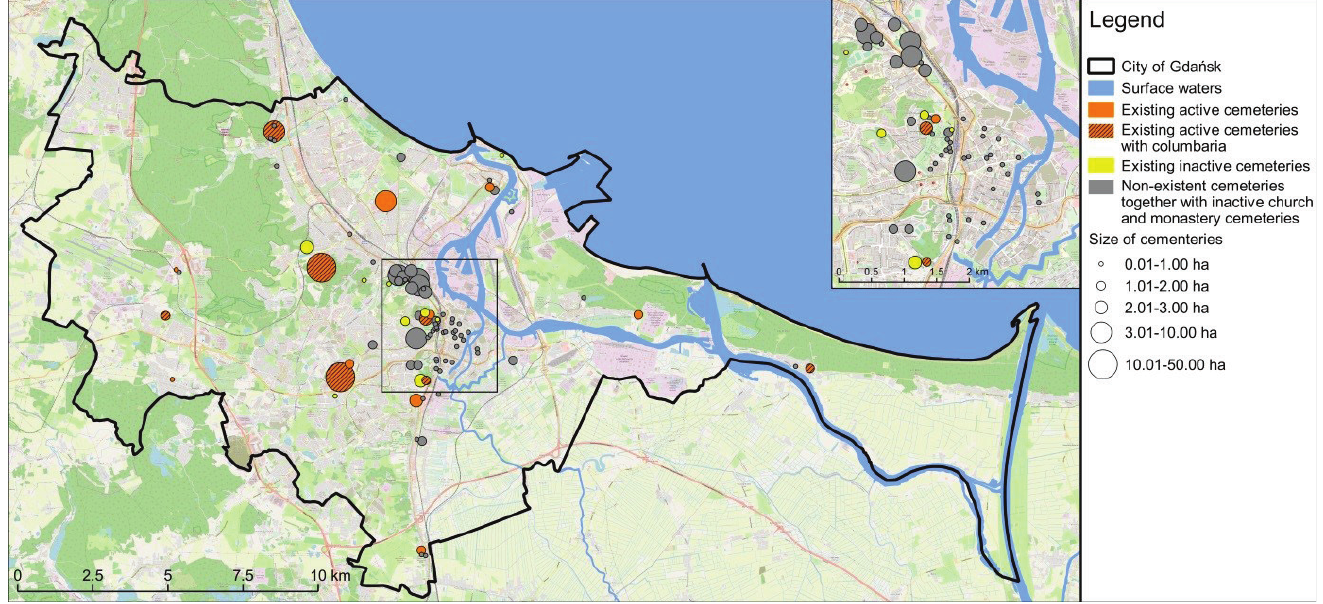
Figure 6. Cemeteries by their status. Source: Own elaboration based on Labenz (1999),